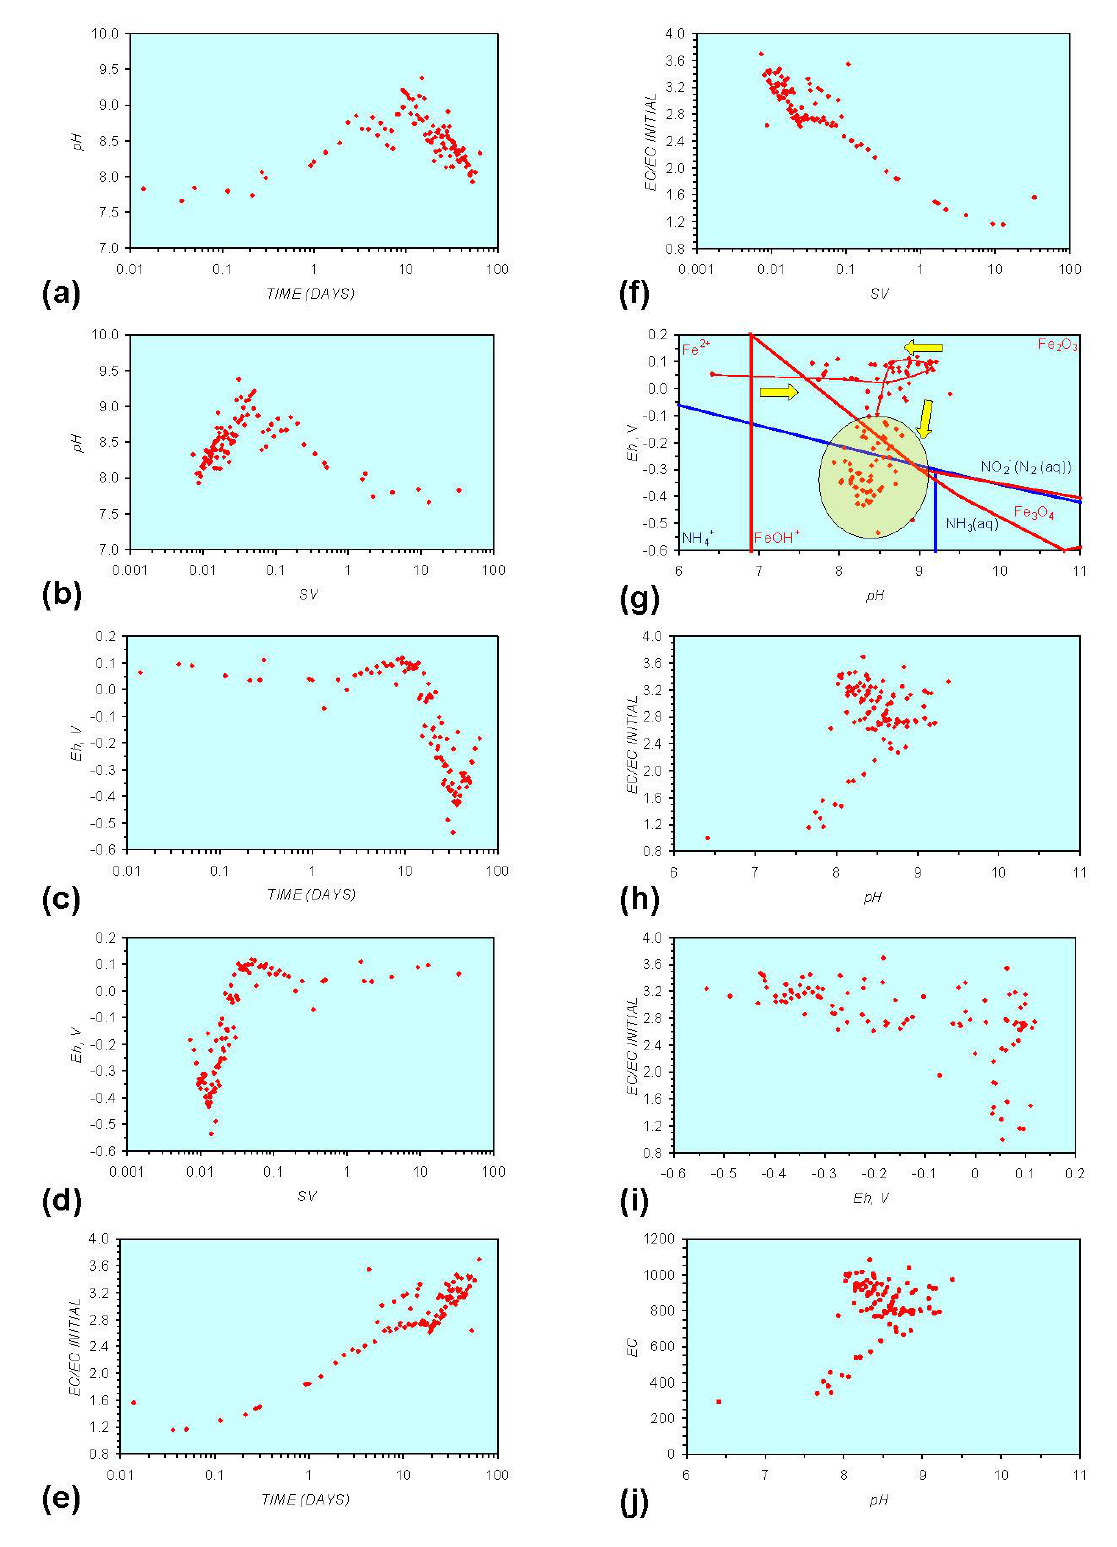
Figure A10. MR10: Ca-montmorillonite + n-Fe 0 , fresh water. (a) pH vs. Time; (b) pH vs. SV; (c) Eh vs. time; (d) Eh vs. SV; (e) EC/EC Initial vs. time; (f) EC/EC Initial vs. SV; (g) Eh vs. pH (SRE ringed); (h) pH vs. EC/EC Initial; (i) Eh vs. EC/EC Initial; (j) pH vs. E(C) Arrows indicate decreasing SV and increasing